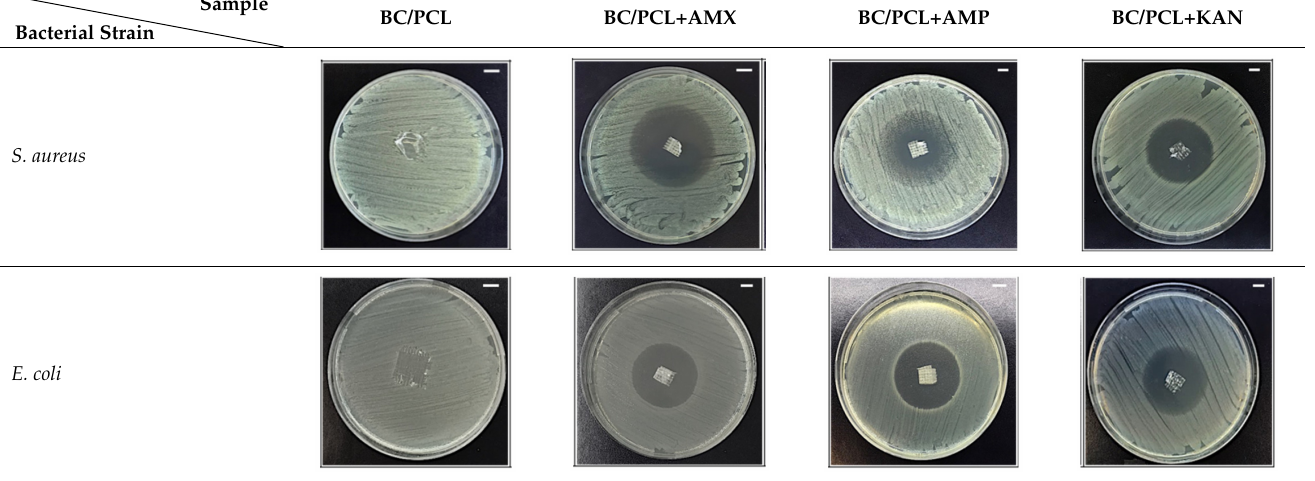
Table 4. Antibacterial properties of the EHD-3D printed patches against S. aureus and E. coli bacteria. All scale bars indicate 10 mm. Bacterial Strain